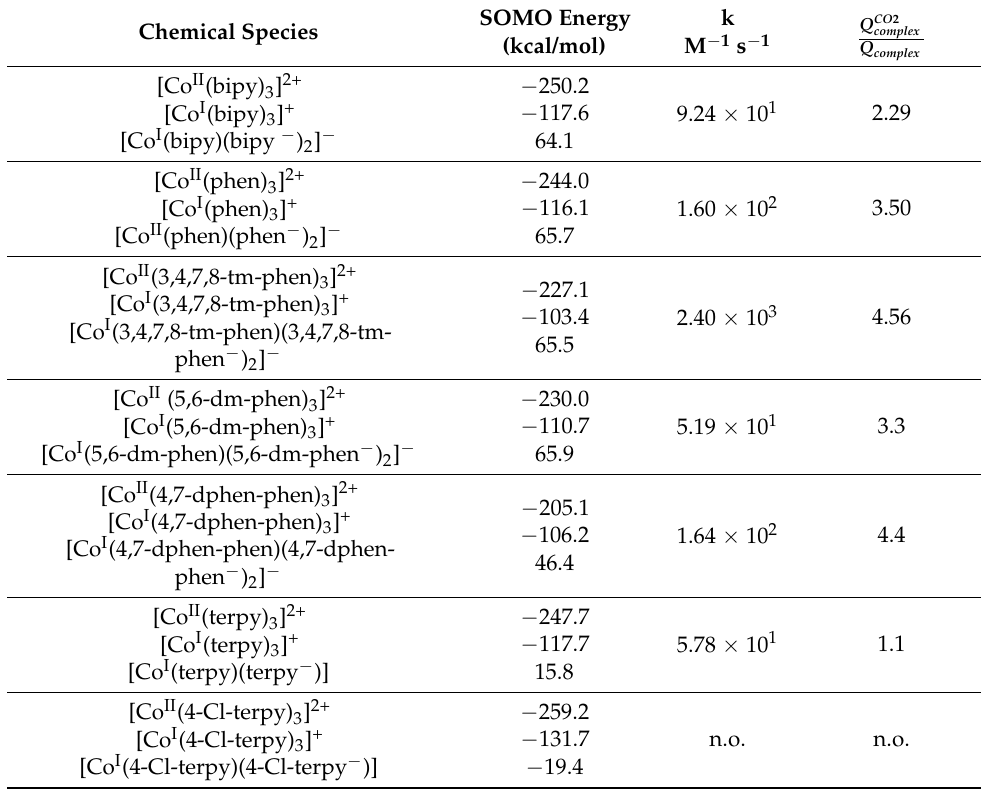
Table 2. SOMO energy values for the proposed species for the reduction of [Co II (L) 3 ] 2+ and [Co II (L ´ ) 2 ] 2+ cations and their catalytic constant values for mediated CO 2